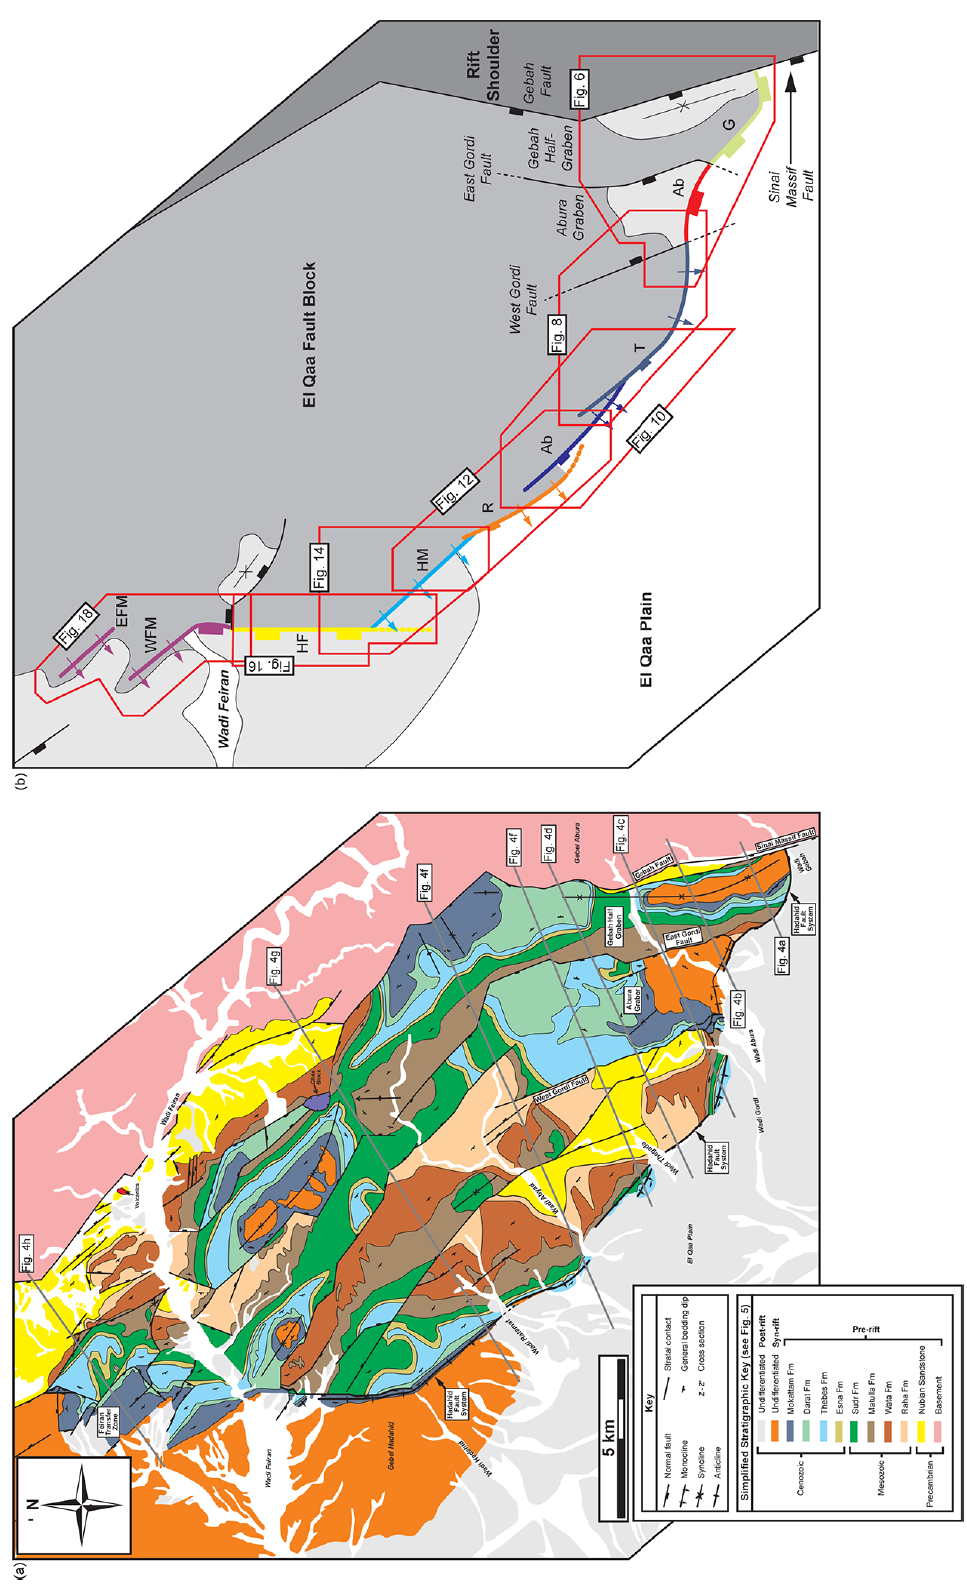
Figure 3. (a) Simplified geologic map of the Hadahid Fault Block (see Fig. 2a for location) (based on Moustafa and El-Raey, 1993 and new mapping undertaken as part of this study). The locations of cross section in Fig. 4 are indicated. (b) Simplified geological map highlighting the constituent segments of the Hadahid Fault